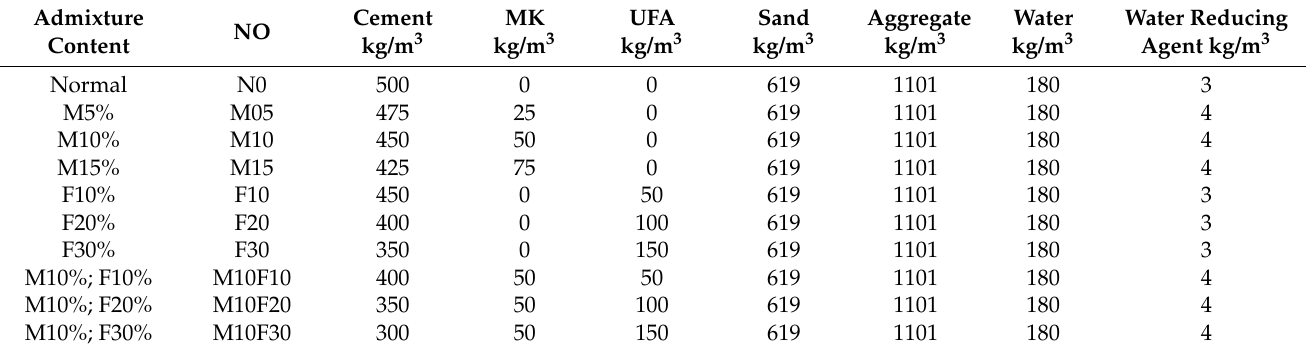
Table 2. Mix proportion of admixture concrete.